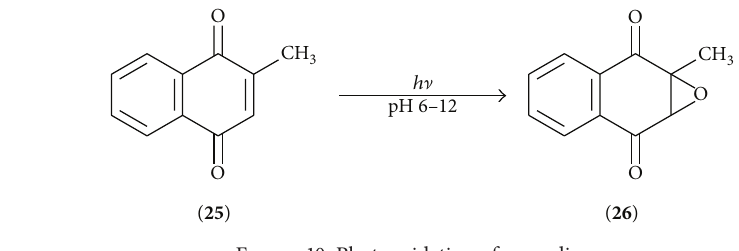
Figure 10: Photooxidation of menadione.